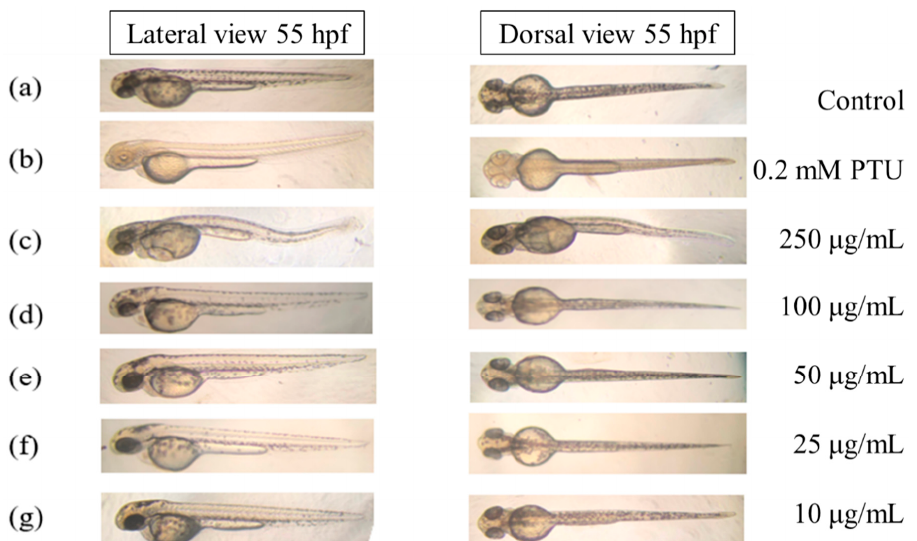
Figure 3. Depigmenting effect of ethanol extracts from fermented-nongermination black soy milk on melanogenesis in zebrafish embryos in an in vivo phenotype-based system. Representative images of synchronized zebrafish embryos treated with ethanol extracts from fermented-nongermination black soy milk at 55 hpf (48 h treatment). Depigmenting efficacy of ethanol extracts from fermented-nongermination black soy milk on zebrafish embryos were photographed under a stereomicroscope at the same magnification. PTU, phenylthiourea; hpf, h post fertilization. ( a ) Zebrafish embryos without treatment as a control, ( b ) 0.2 mM PTU as a standard positive control, ( c ) 250 µg/mL, ( d ) 100 µg/mL, ( e ) 50 µg/mL, ( f ) 25 µg/mL, and ( g ) 10 µg/mL.